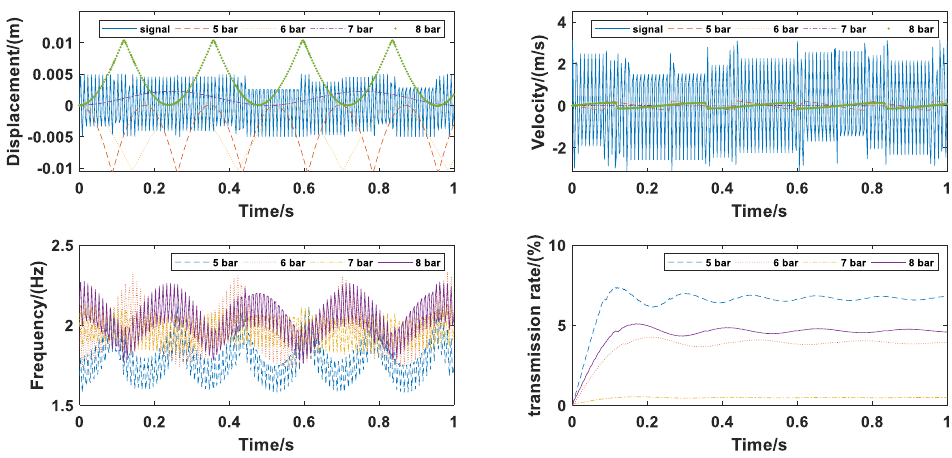
Figure 9. Simulation results under 100 Hz, 5 mm amplitude vibration.